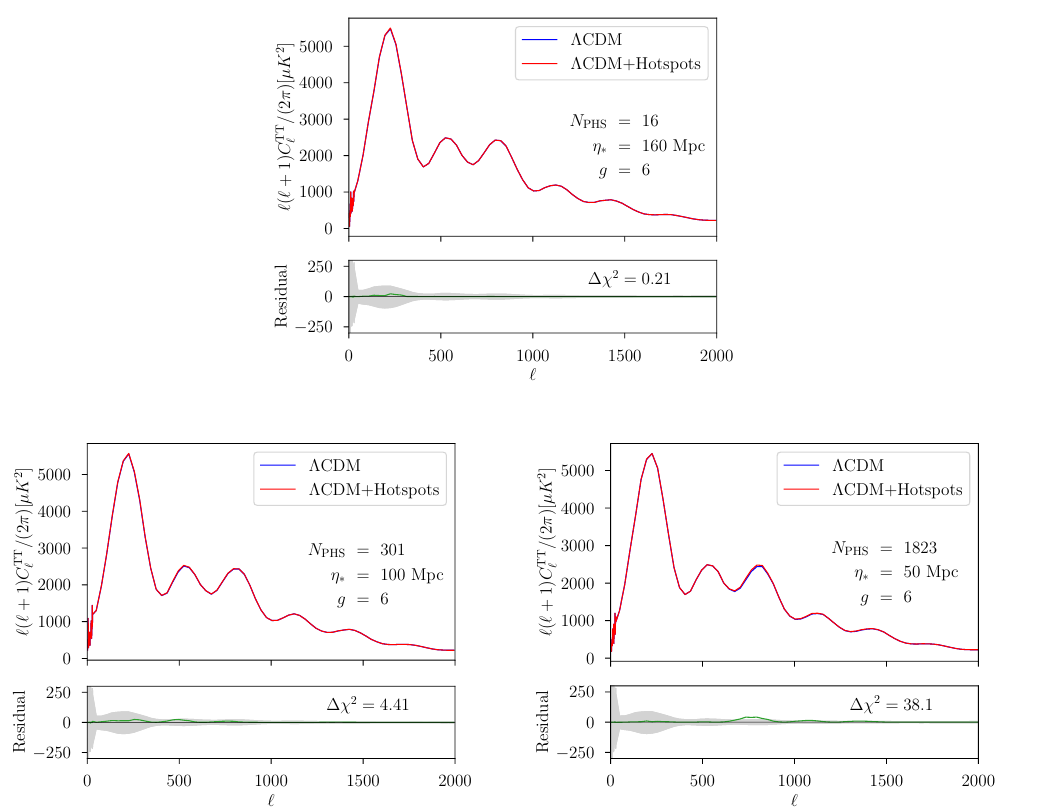
spectrum of the CMB using best fit ΛCDM input parameters in eq. (4.1) with Figure 7 . D TT ‘ (red lines) and without (blue lines) PHS signals injected in the sky using a resolution parameter N side = 2048 . The differences between the two distributions are shown in green lines, and the shaded regions correspond to 1 σ uncertainty, taken from the Planck 2018 data [31]. Here we show examples with g = 6 . Several benchmarks of η and the number of PHS signals corresponding to ∗ h N 1 σ i bounds in table 1 are chosen. The corresponding ∆ χ 2 excess based on the goodness-of-fit test is shown in each